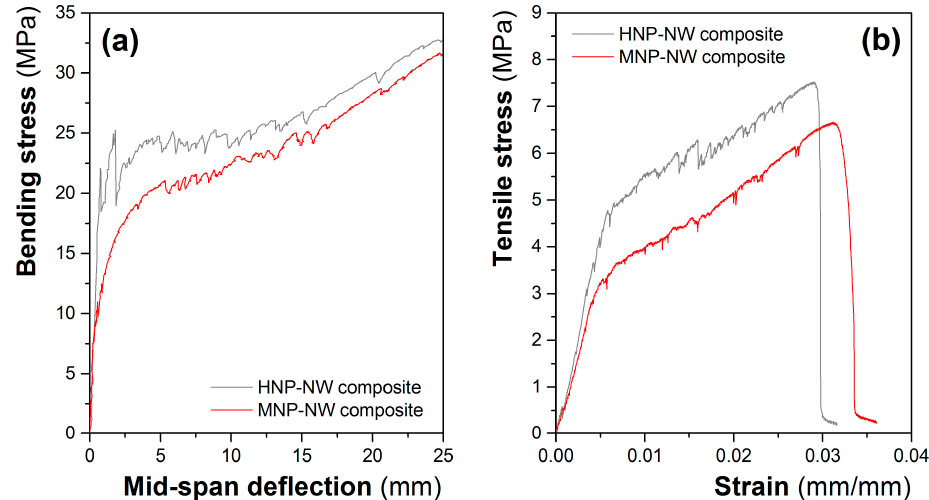
Figure 5. Typical bending ( a ) and tensile curves ( b ) obtained for the composites prepared with HNP-NW and MNP-NW nonwovens. Table 3. Average values and standard deviation of LOP, MOR, E modulus, and toughness, obtained from bending tests and increase of these values for the composites prepared with the HNP-NW fabric with respect to the ones prepared with the MNP-NW fabrics.